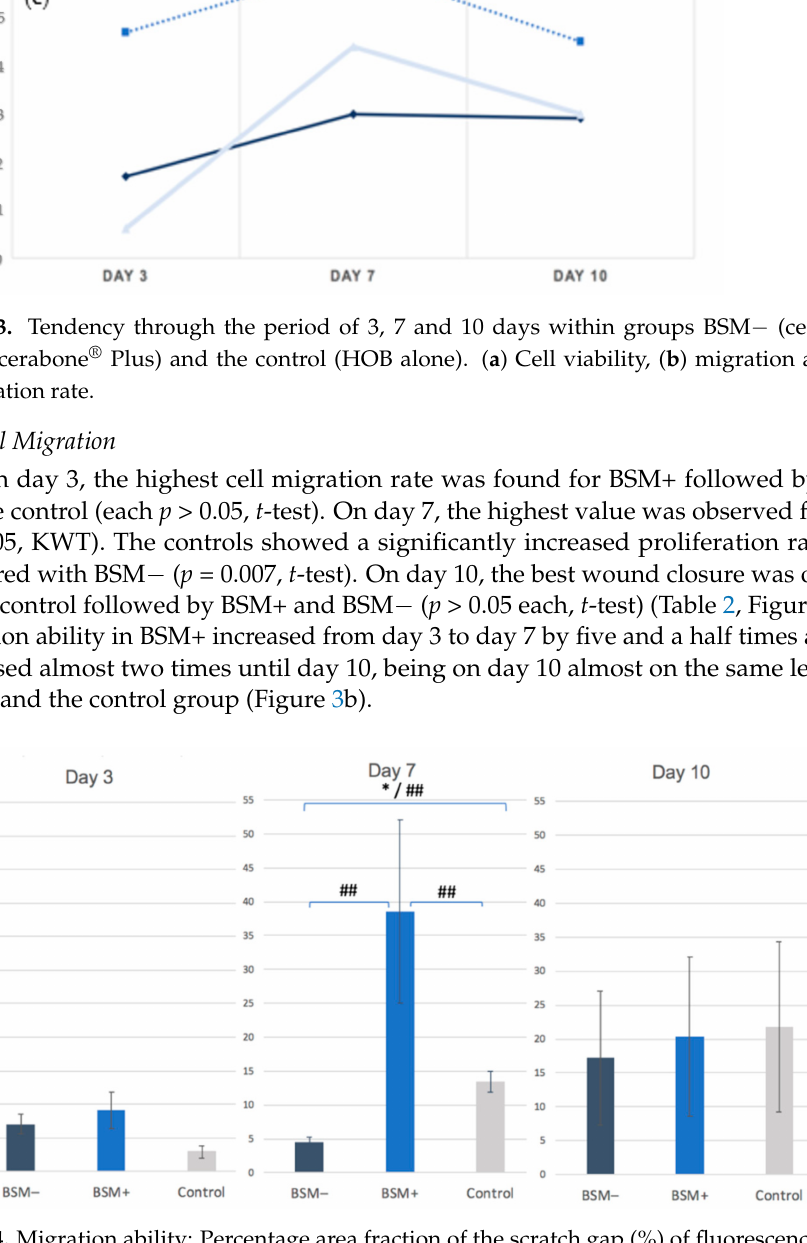
Figure 4. Migration ability: Percentage area fraction of the scratch gap (%) of fluorescence-stained HOBs at a ten-fold magnification for BSM − (cerabone ® ), BSM+ (cerabone ® Plus including HA) and the control (HOB alone) on days 3, 7 and 10. * = p ≤ 0.05, t -test; ## = p ≤ 0.05,